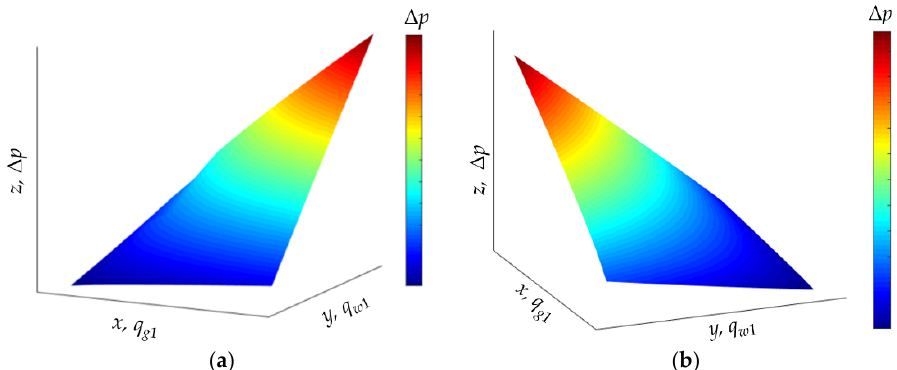
Figure 3. The pressure loss of the two pipes with different flow rate pairs: ( a ) the first pipe; ( b ) the second pipe.